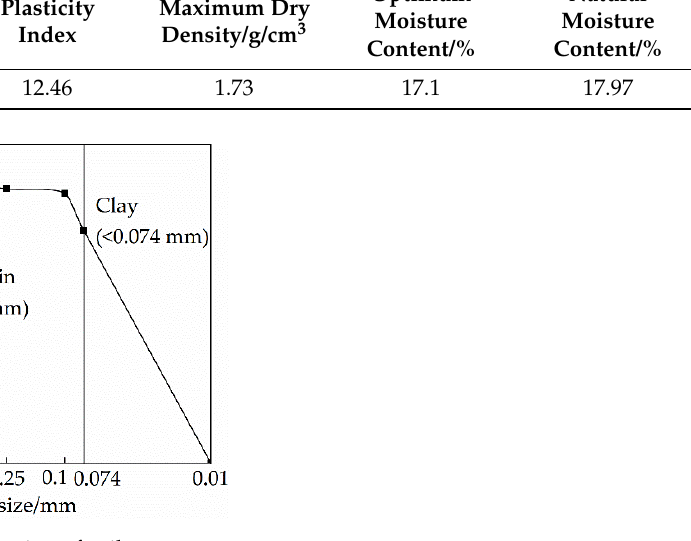
Table 1. Physical properties of soil.